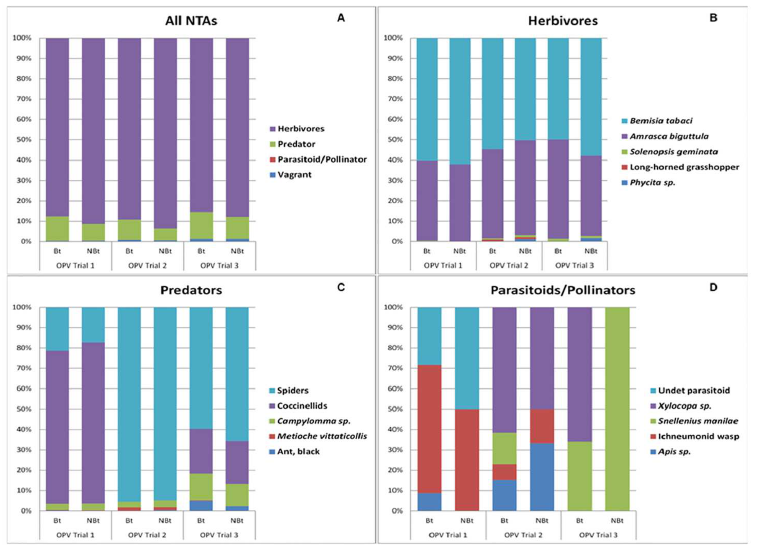
Fig 1. Composition of non-target arthropod (NTA) communities in Bt and non-Bt eggplants. (a) All (or Total) NTAs communities; (b) Herbivores; (c) Predators; (d) Parasitoidsand Pollinators